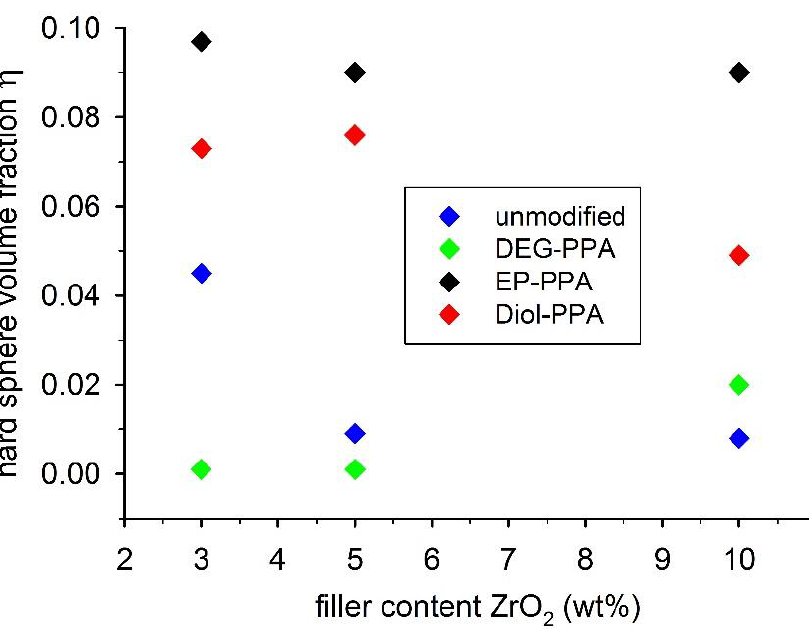
Figure 7. Hard sphere volume fraction of ZrO 2 nanoparticles with different surface modifications and incorporated into the epoxy resin matrix with different percentages.